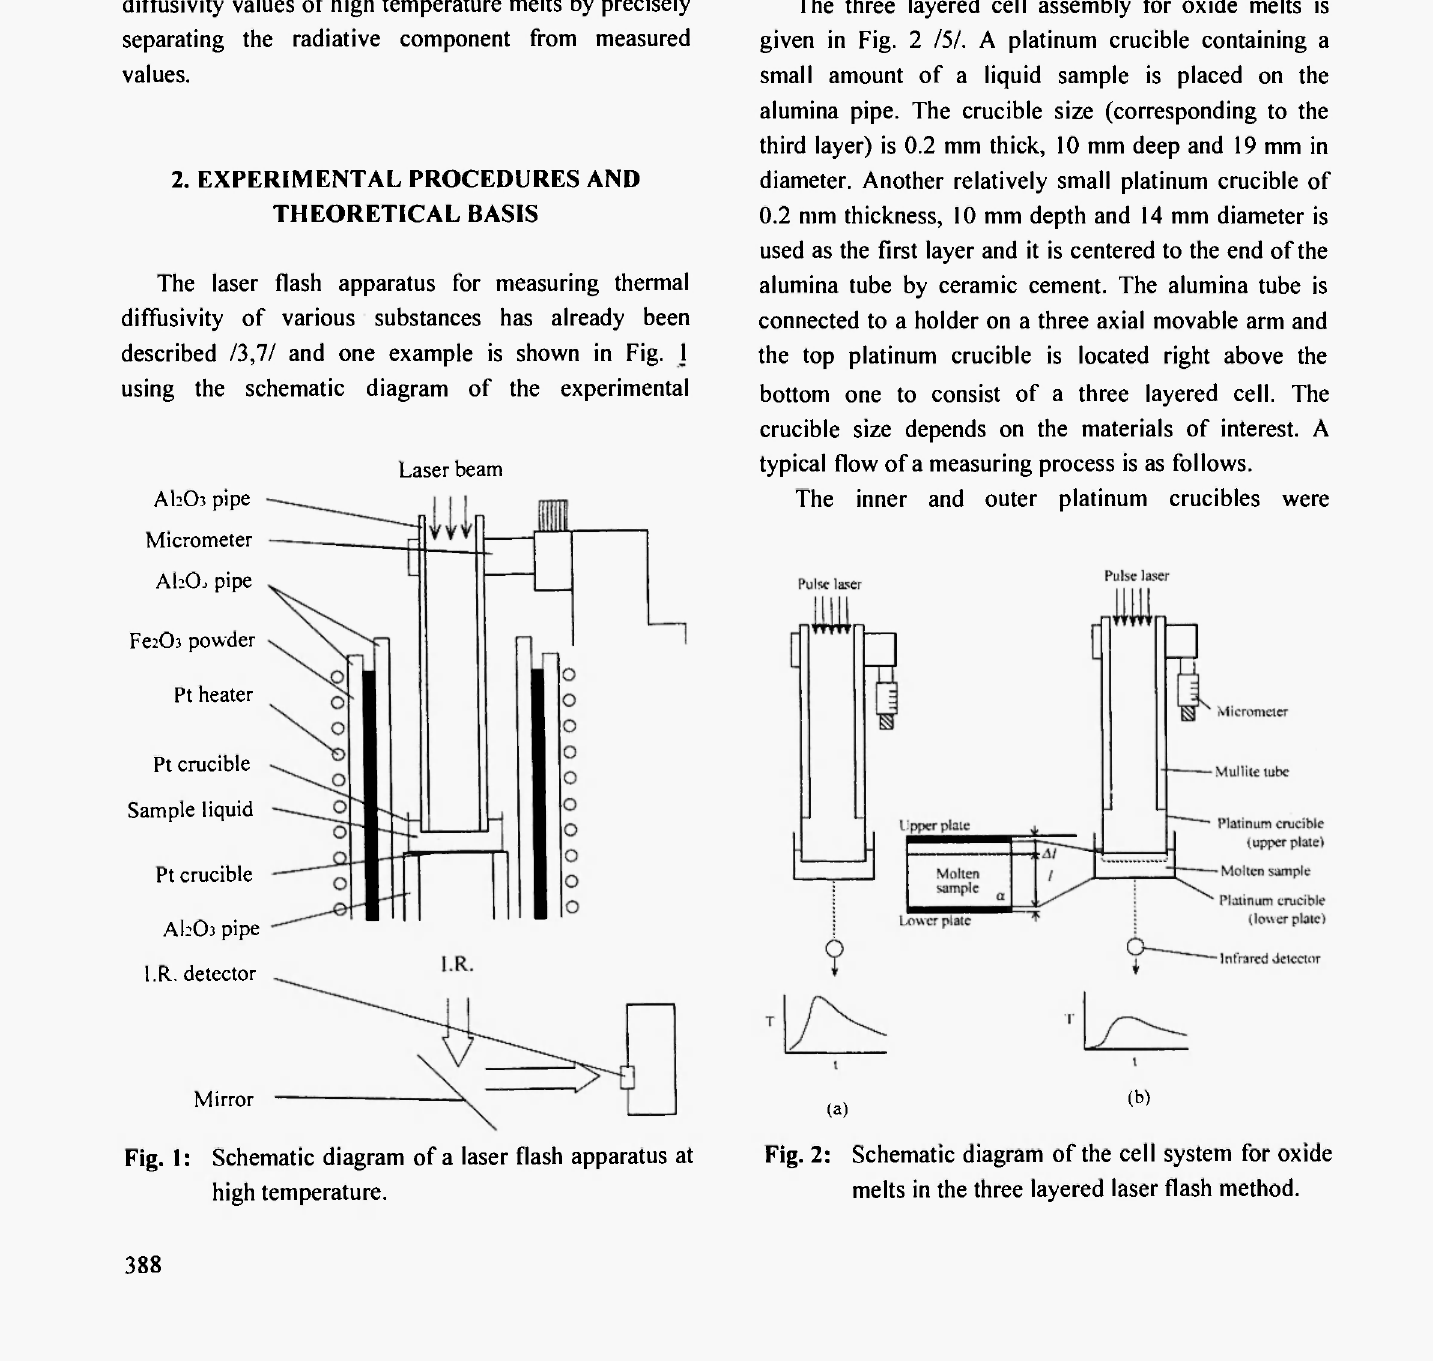
Fig. 2: Schematic diagram of the cell system for oxide melts in the three layered laser flash